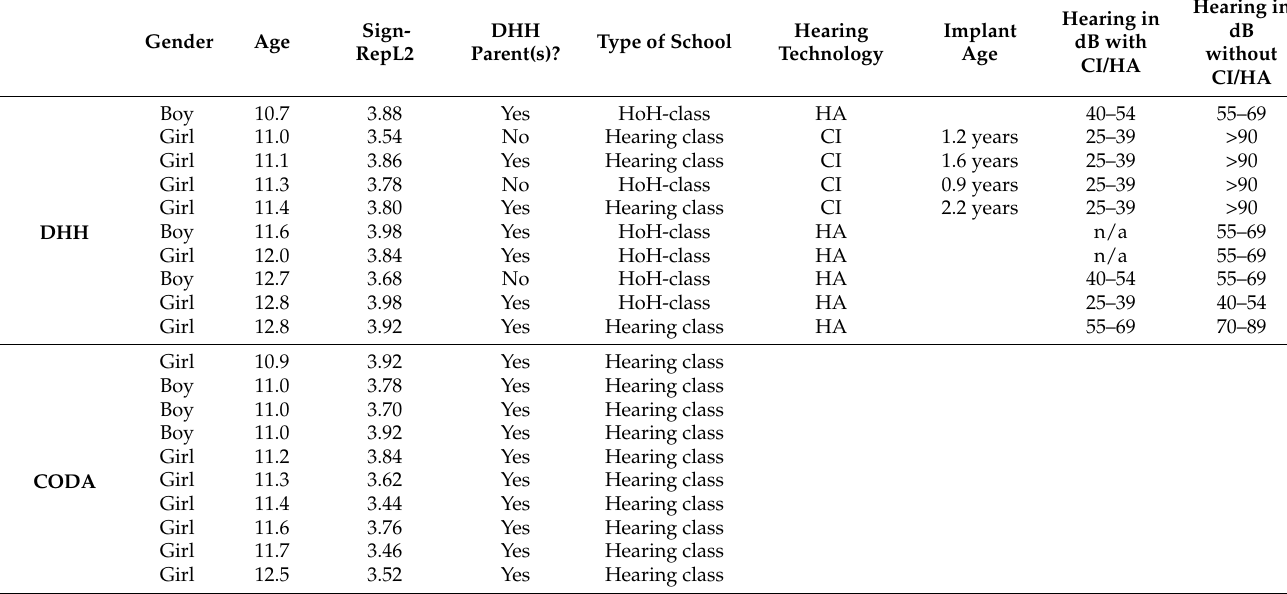
Table 1. The metadata of the participants. The table displays the participants’ gender, age in years and months, SignRepL2 (STS-test) results (4.0 is the maximum), if they have DHH parent(s), their school choice (hearing class, or a hard of hearing, HoH-class), hearing technology (cochlear implants or hearing aids), if having CI–their implant age as well as their hearing degree with and without hearing